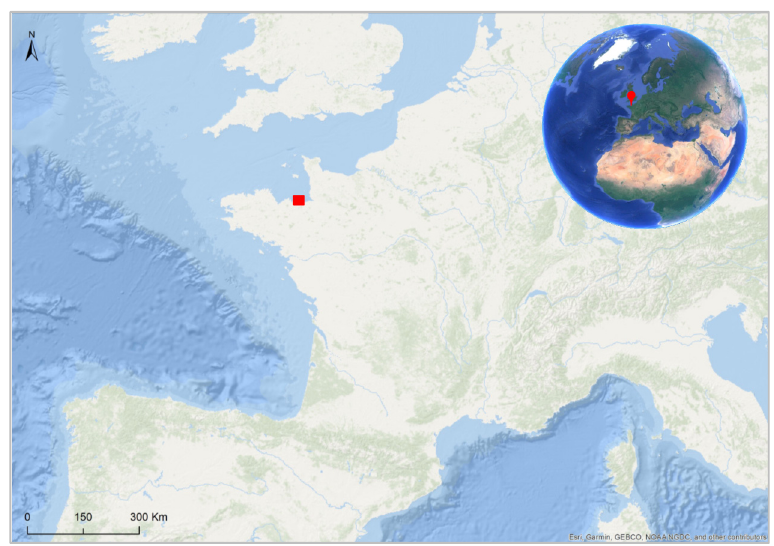
Figure 1. Location of the study on the Emerald Coast (France).